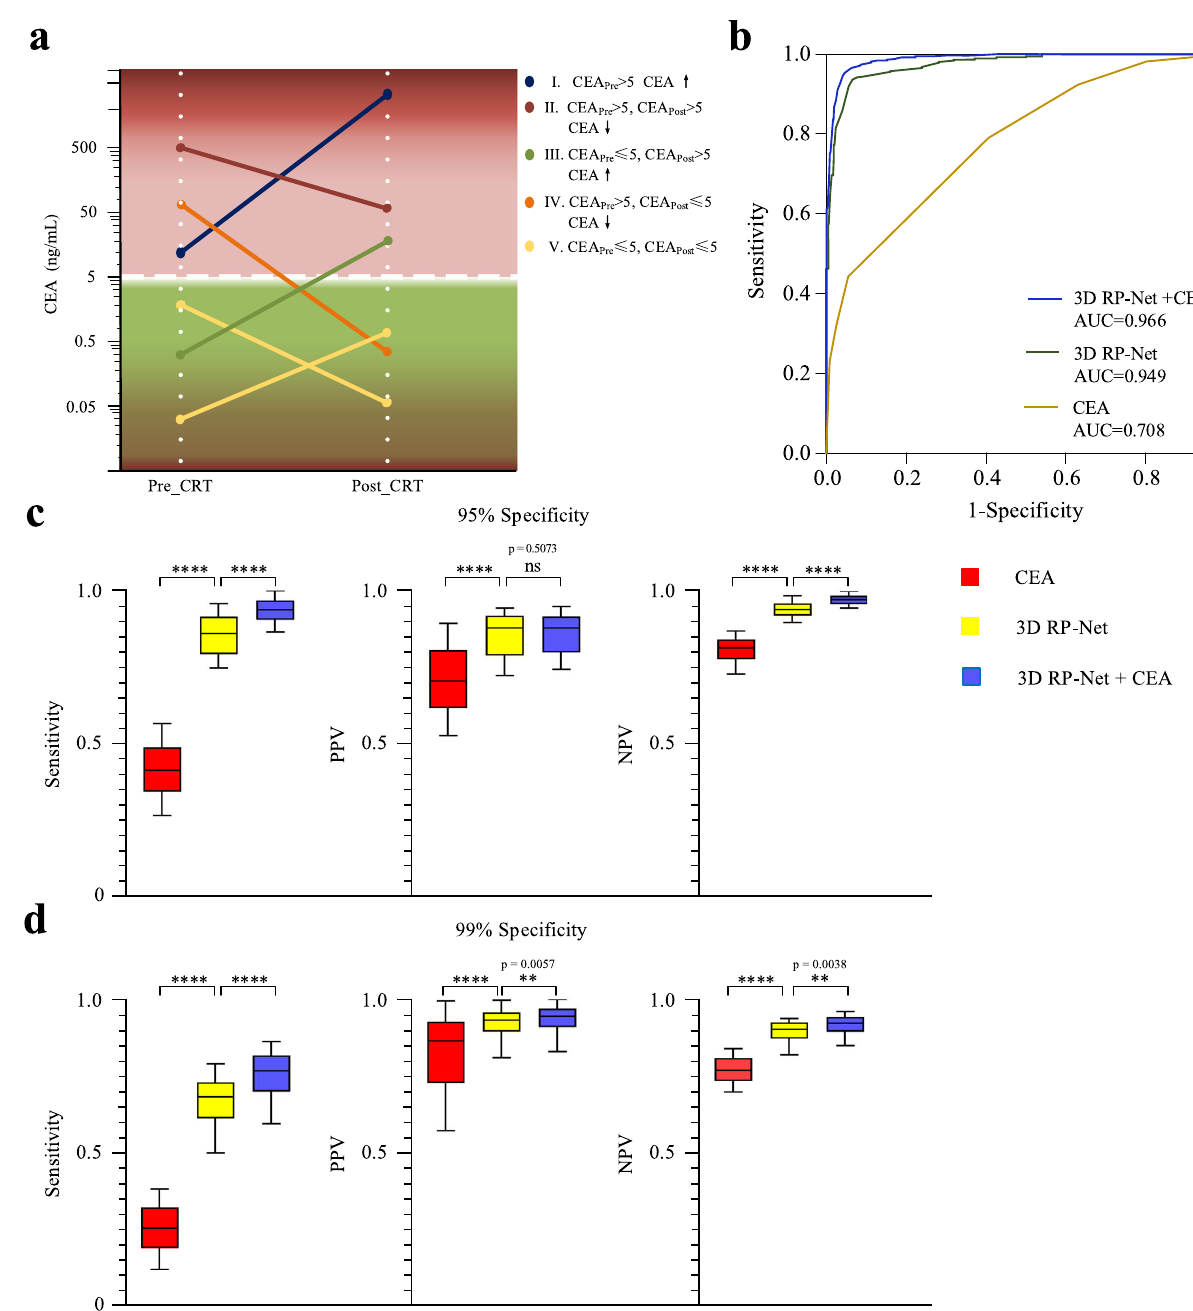
Fig. 5 Integration of imaging and blood-based biomarkers. a De fi nition of fi ve discrete categories of blood marker response based on the clearance patterns of CEA level before and after CRT. b ROC curves for three different models: combined imaging and CEA model, imaging alone, and CEA alone in the internal validation cohort. c Comparison of response prediction performance of different models at 95% speci fi city. d same as ( c ) except for 99% speci fi city. In the box plots, the central line represents the median, the bounds of box correspond to the fi rst and third quartiles, and the whiskers are the minimum and maximum of the data. p values were computed based on the two-sided t test ( n = 160 patients) between the prediction models as indicated in ( c , d ) and adjusted for multiple comparisons. CEA, carcinoembryonic antigen; PPV, positive predictive value; NPV, negative predictive value. ns, not signi fi cant, p ≥ 0.05; * 0.01 ≤ p < 0.05; ** 0.001 ≤ p < 0.01; *** 0.0001 ≤ p < 0.001; **** p <